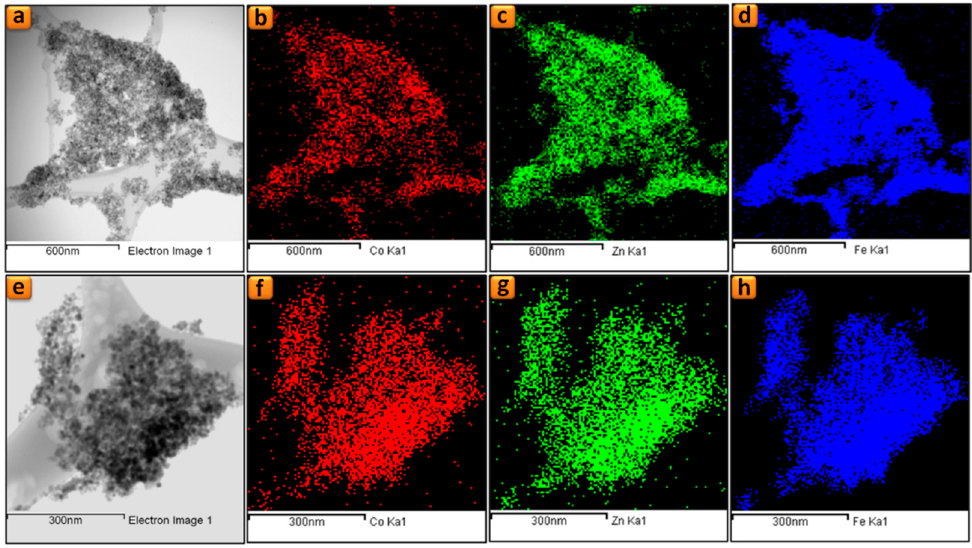
Figure 3. Elemental mapping for Co_2 ( a – d ) and Co_4 ( e–h ) samples: ( a,b ) BF-STEM images, ( b,f ) Co maps, ( c,g ) Zn maps and ( d,h ) Fe maps.